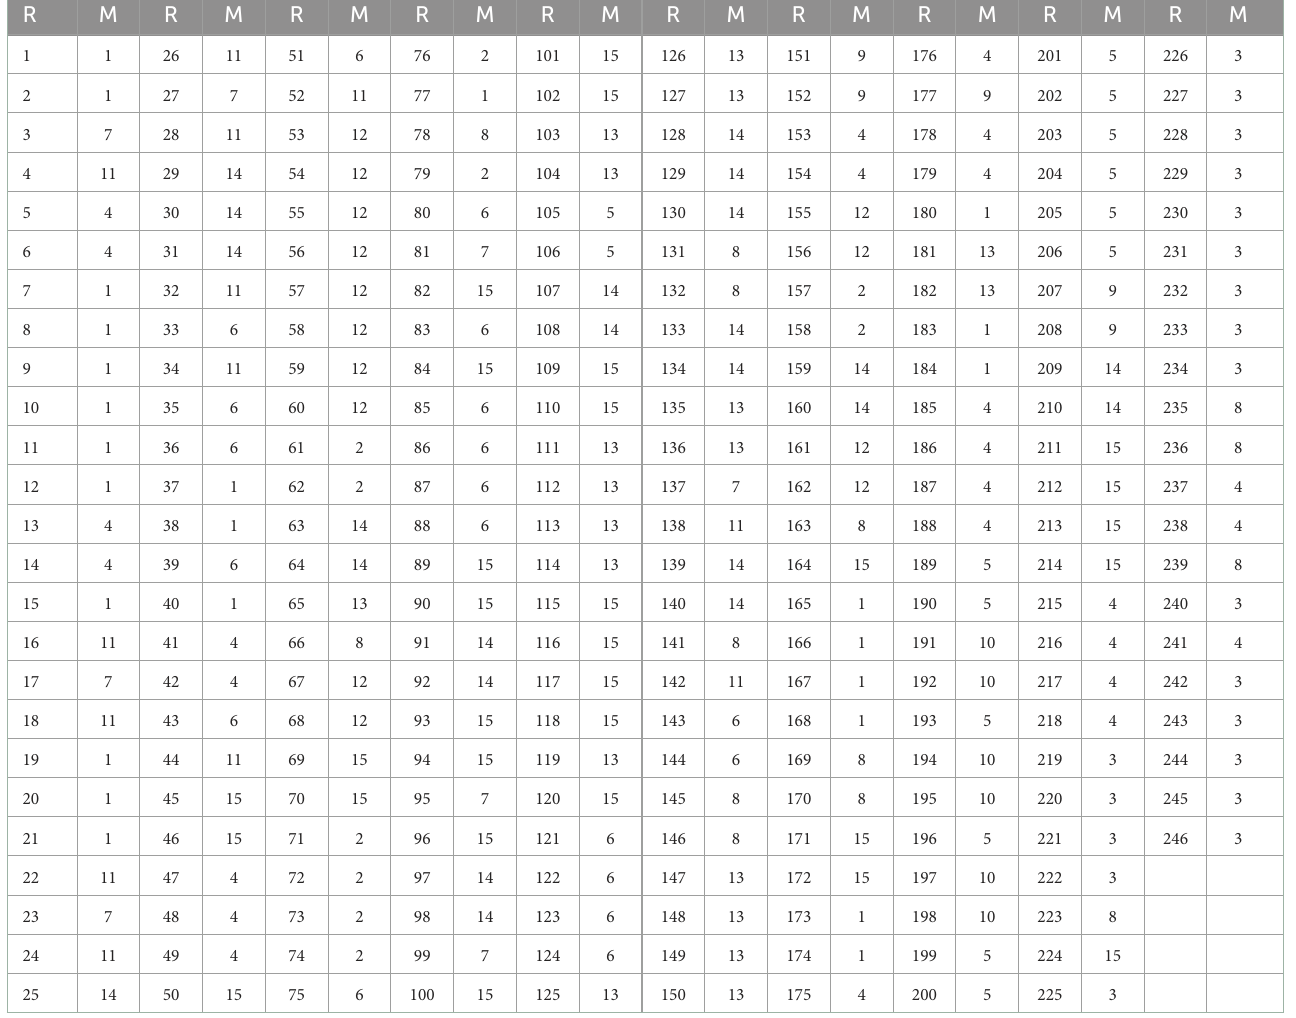
TABLE 1 Region a-priori Affiliation, columns marked “R” are region numbers and “M” columns are a-priori modular affiliations.